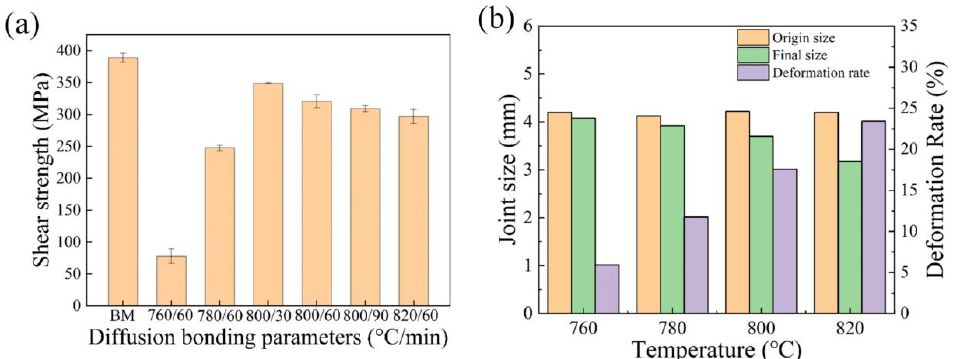
Figure 7. Influence of bonding parameters on shear strength and deformation of diffusion interface. ( a ) bonding temperature and holding time, and ( b ) deformation rate of the joints.